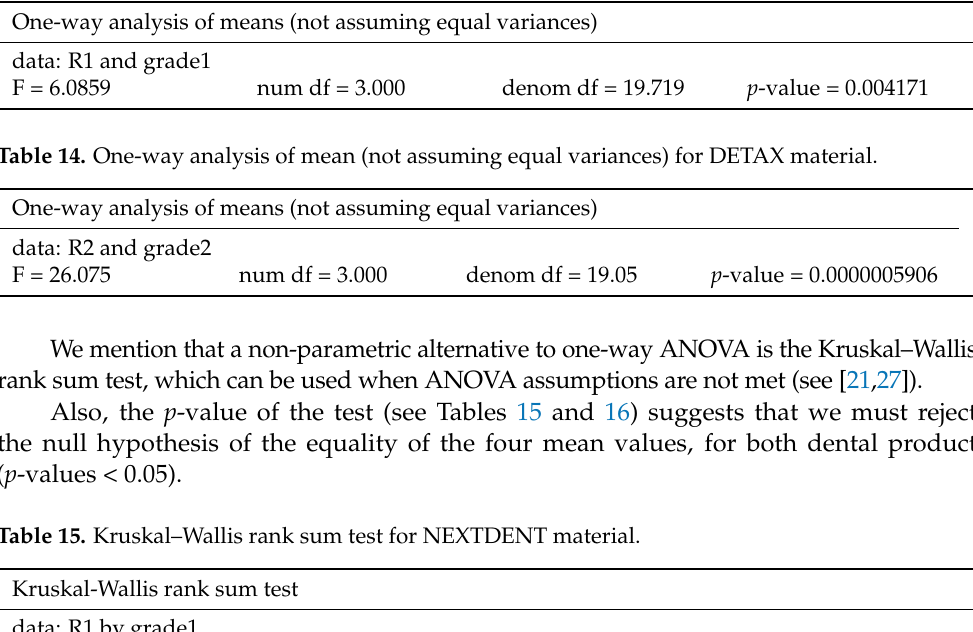
Table 13. One-way analysis of mean (not assuming equal variances) for NEXTDENT material. One-way analysis of means (not assuming equal variances) data: R1 and grade1